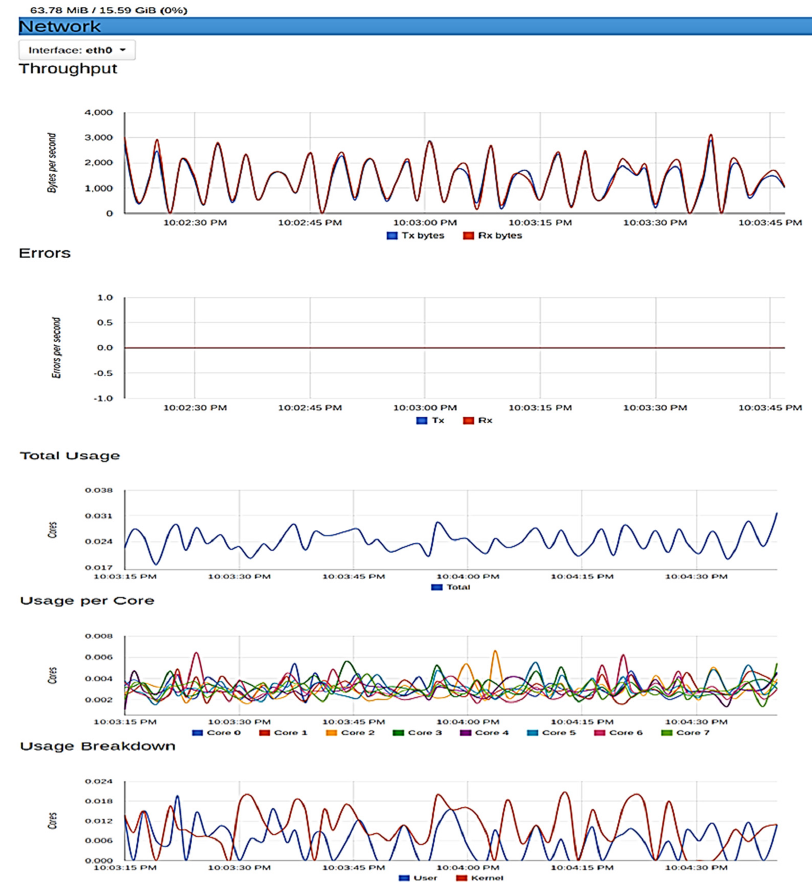
Figure 10. Resource usage for Peer0 and organization 2.